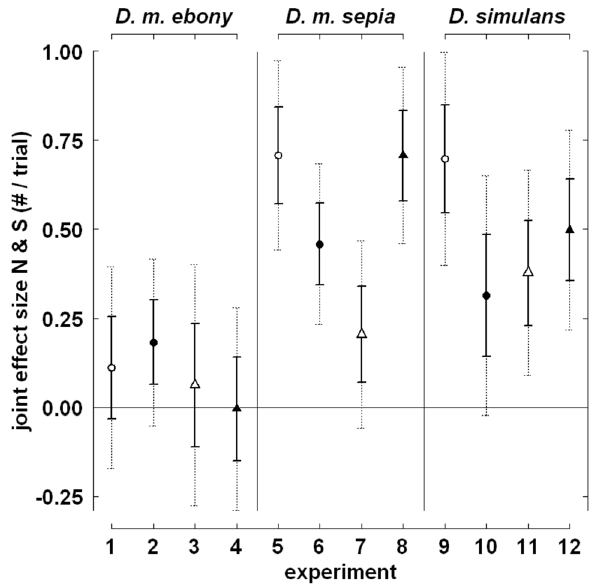
Figure 8. Interaction effects on the ln-transformed odds (i.e. logits) of fertilization of female Drosophila. Depicted are the parameter estimates of the joint effect size of the total number of flies (N) and sex ratio (S); data is from the twelve experiments presented in Wallace [18]. Symbols indicate trial duration (30 min: open symbols, 60 min: filled symbols), and the number of mating chambers in the experiment (1: circles, 2: triangles). Solid and dotted error bars indicate the standard error and the 95% confidence intervals of these parameter estimates, respectively. Positive joint effect sizes can be interpreted as indicating that the positive effect of the total number of flies was more pronounced when sex ratio was higher (more male-biased), and vice